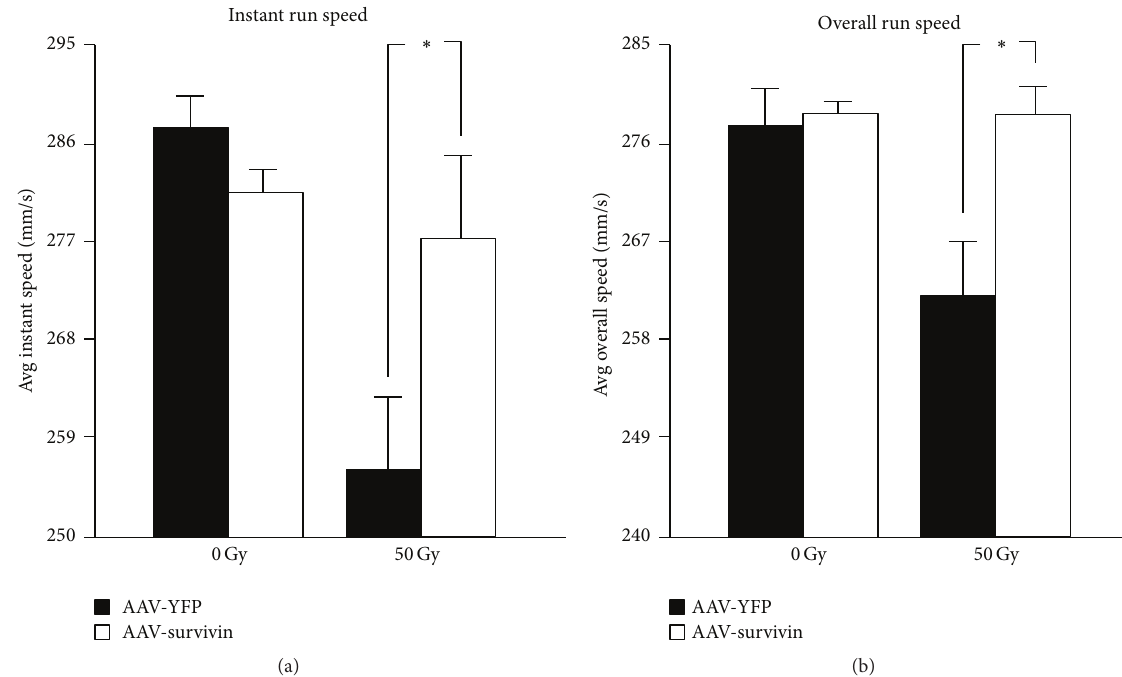
Figure 3: TreadScan software was used to track functional ability. Prior to beginning the radiation protocol, both groups of mice performed similarly on the treadmill. However, following 50 Gy of radiation, YFP mice showed a significant decrease in (a) instant run speed and (b) overallspeed,whileperformanceofsurvivinmiceremainedrelativelyunaffected.Student’s 𝑡 -testwasusedtocomparethegroupsand 𝑝 ≤ 0.05 demonstratedasignificantresult.Dataaremean ± s.d.; 𝑛 = 10 pergroup.Student’s 𝑡 -test: 𝑝 InstantRunSpeed = 0.05, 𝑝 OverallRunSpeed = 0.01. ∗ indicates significance.